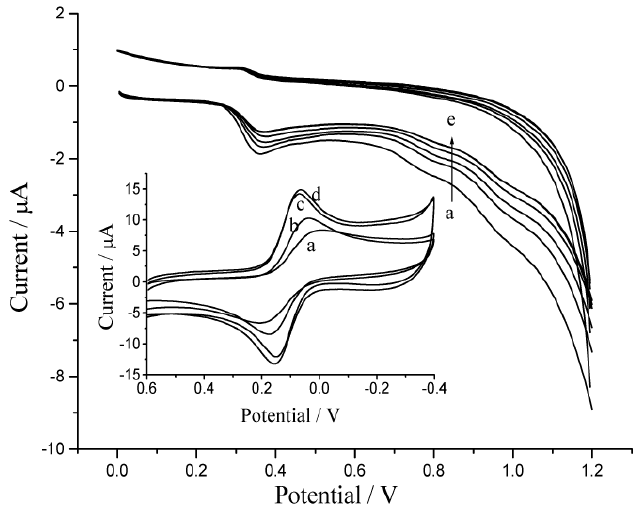
Figure 4. Cyclic voltammograms of 5.0 × 10 − 5 mol L − 1 luminol in PBS of pH 8.0 with the addition of DNA for (a) 0, (b) 2.8 × 10 − 7 mol L − 1 , (c) 5.5 × 10 − 7 mol L − 1 , (d) 8.2 × 10 − 7 mol L − 1 and (e) 1.1 × 10 − 6 mol L − 1 . Insert are cyclic voltammograms on (a) bare GC